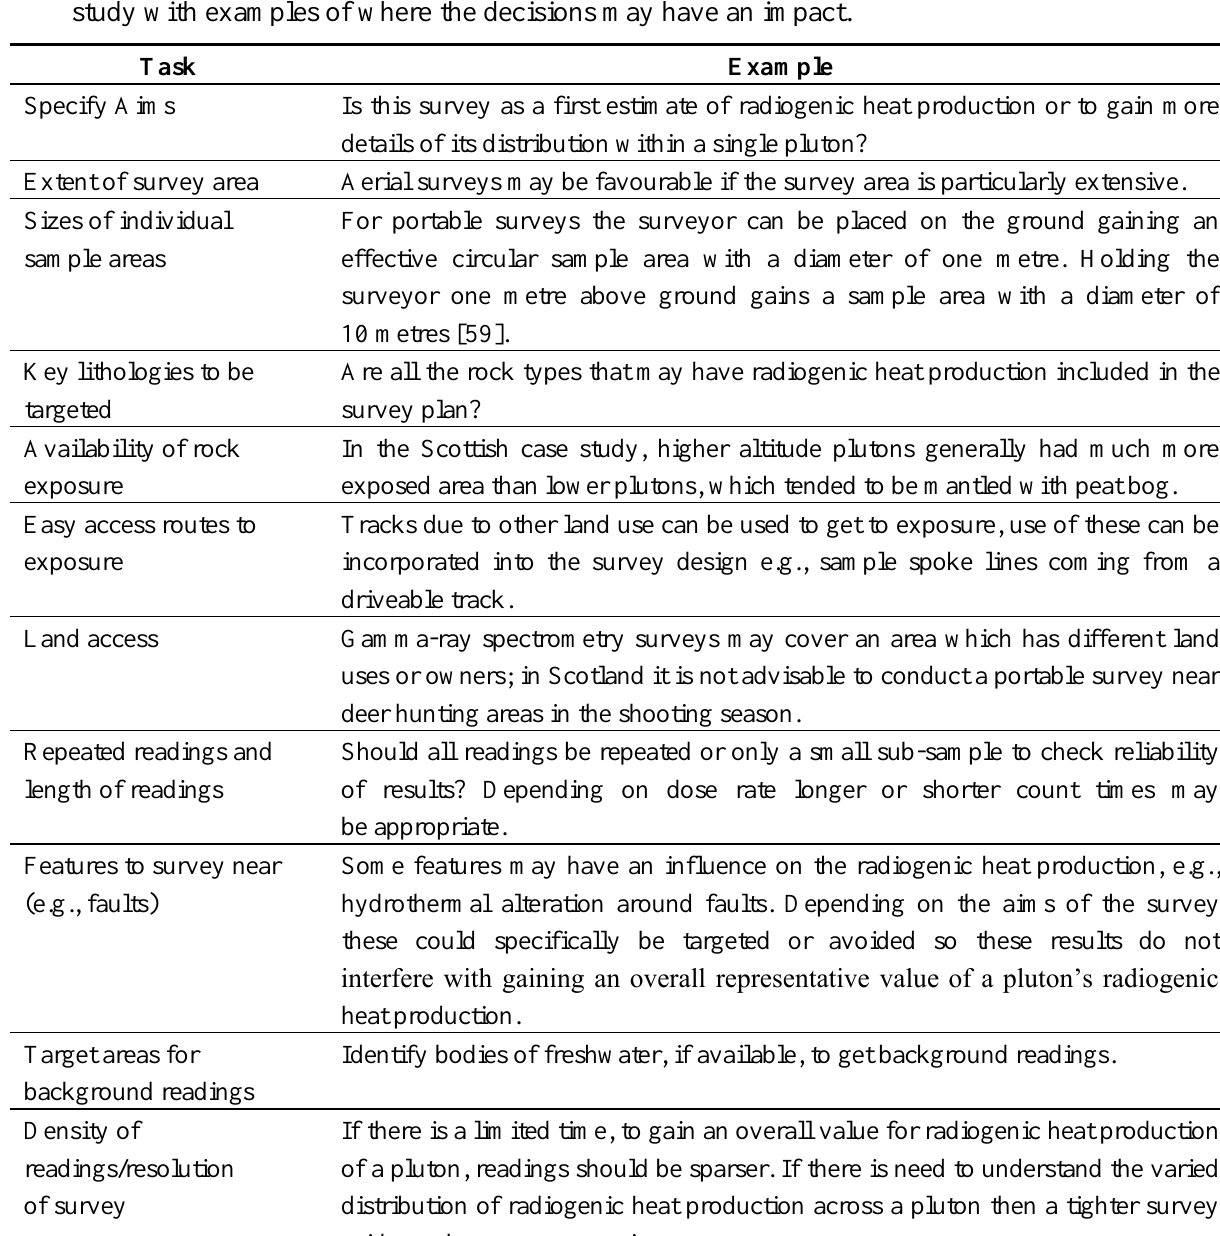
Table 1. Tasks worth considering during a ground based portable gamma-ray spectrometry study with examples of where the decisions may have an